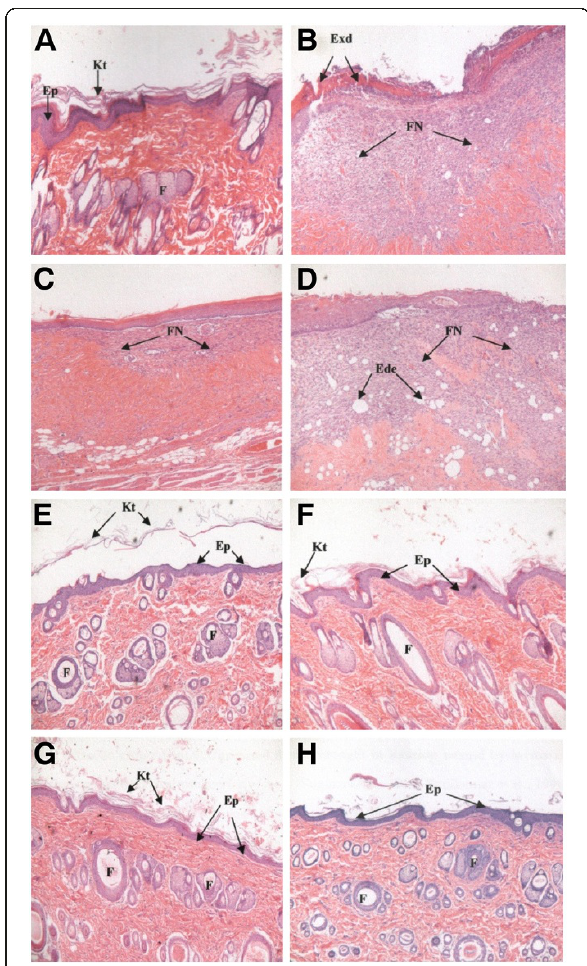
Figure 1 Histological features of partial-thickness burn wounds on day 14 after burn injury. Hematoxylin and eosin stains of A ) normal skin; B ) untreated wound; C ) NSS-treated wound; D ) Tween 20-treated wound; E ) hexane extract-treated wound; F ) ethyl acetate extract-treated wound; G ) methanol extract-treated wound; H ) water extract-treated wound. Ep: epidermis; Kt: keratin; Exd: exudates; FN: fibrinoid necrosis; Ede: edema; F: hair